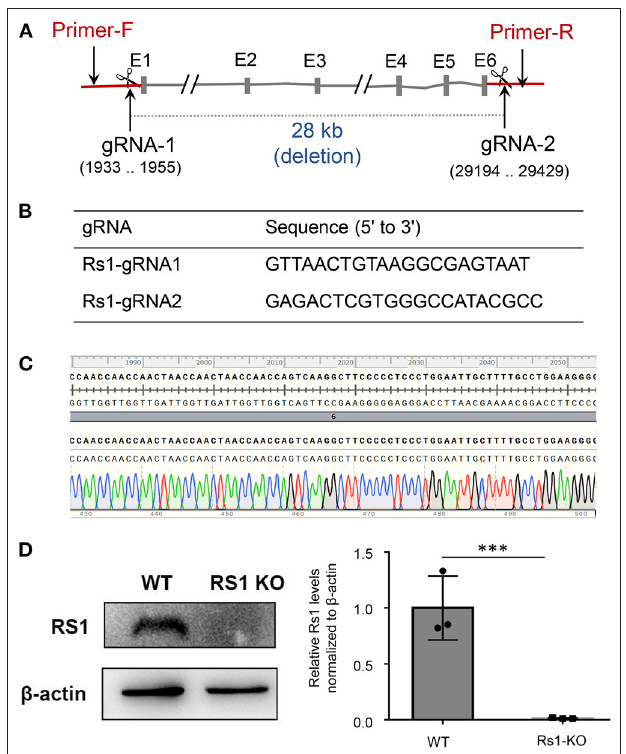
FIGURE 1 | Rs1 − / Y mouse model generation and genotyping strategy. CRISPR/Cas9 genome editing system with two guide RNAs was used to generate the Rs1 − / Y mouse model. (A) In the targeting construct, all coding sequences of Rs1 gene were deleted. Forward primer of genotyping located at the upsteam of gRNA-1 and reverse primer located at the downstream of gRNA-2. (B) gRNA sequencing of Rs1 knockout mice. (C) DNA sequencing analysis revealed 28kb deletion in one founder. (D) The absence of normal Rs1 protein in retinal extracts of Rs1 − / Y mice.